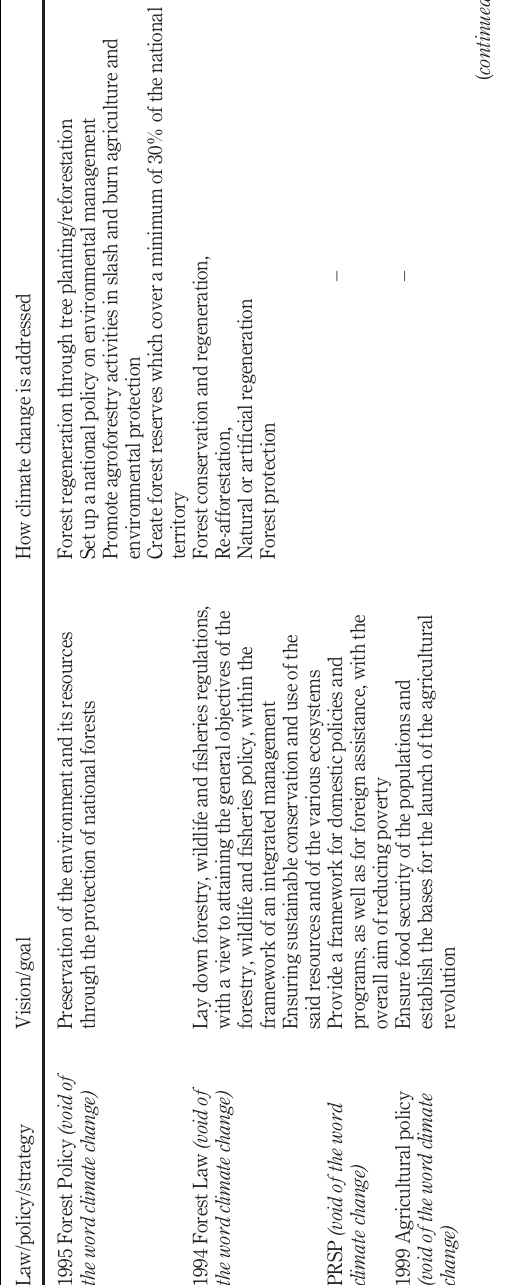
Table I. Characterization